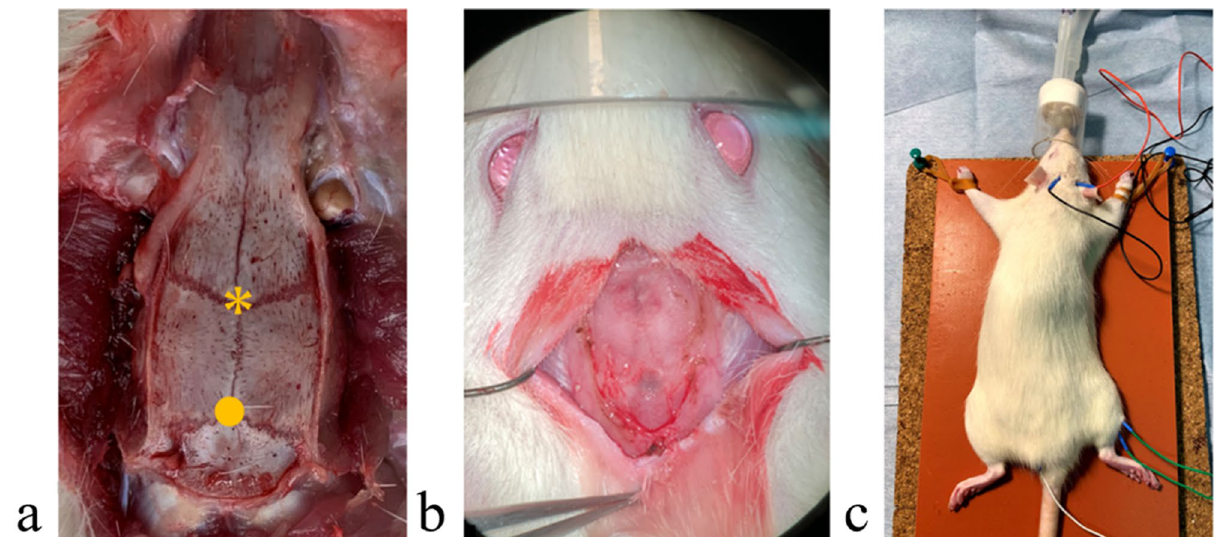
Figure 4. ( a ) Anatomical image of the rat skull seen from above. The asterisk indicates the bregma, and the circle marks the lambda. ( b ) Intraoperative image: skull thinning for a total diameter of 5 mm was performed. The outer plate and diploe of the skull were removed, leaving only the inner plate. The anode was installed on the lambda, and the cathode was installed on the bregma. ( c ) The electrode installation. Transcranial electrical stimulated motor-evoked potentials were recorded under general